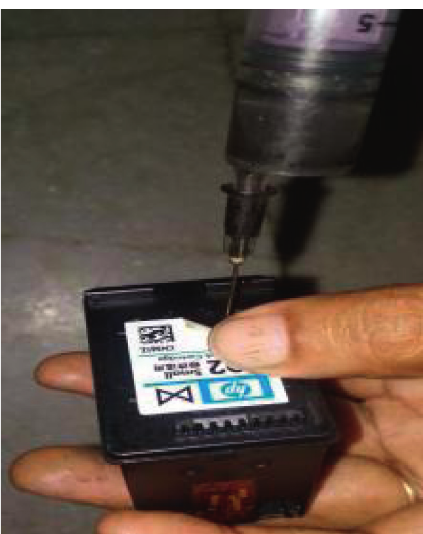
Figure 8: HP 302 cartridge filled with nanoparticle ink NS6130-10- 1300 using ordinary medical